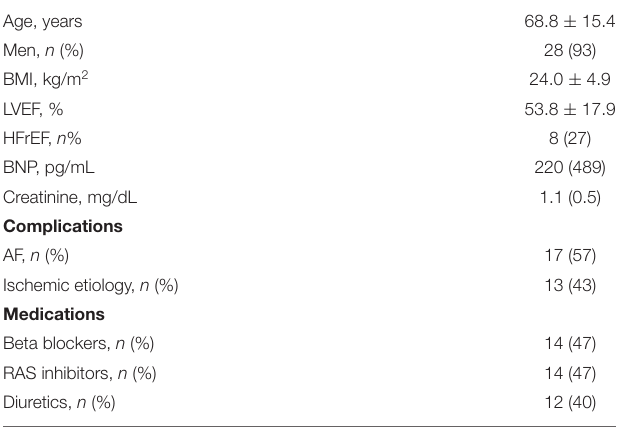
TABLE 3 | Data from the ASC, polysomnographic findings, and additional modified scorings of respiratory events during ASV